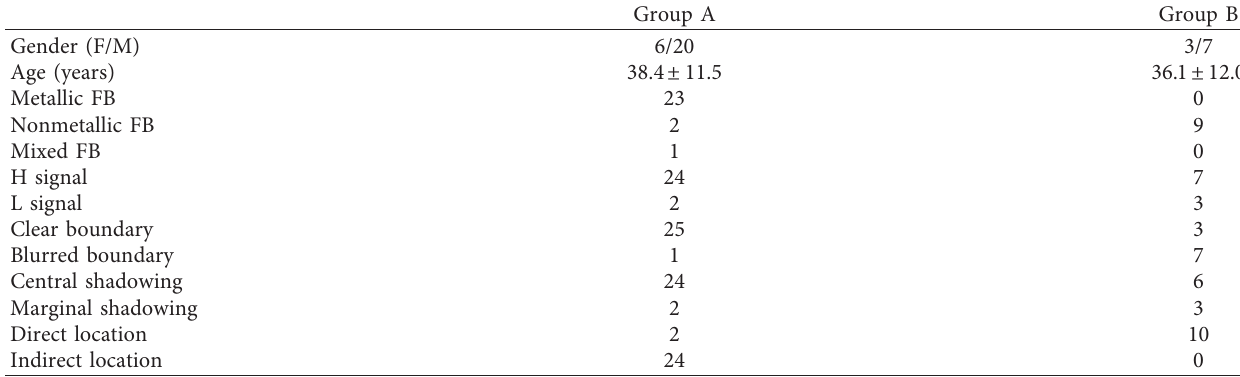
Table 1: Clinical characteristics of all patients.